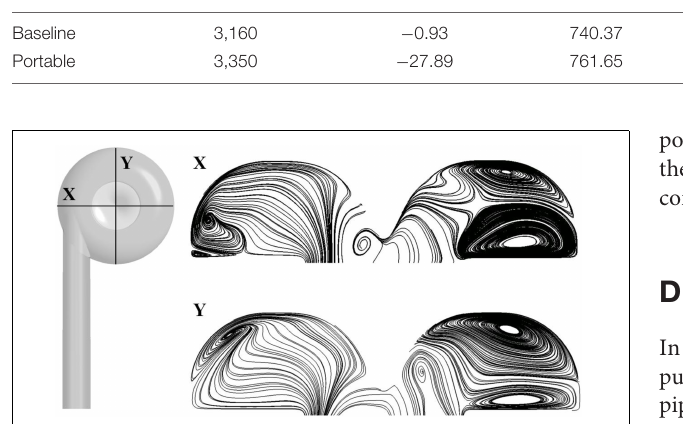
FIGURE 5 | Surface streamlines at two cross-sections in the ring